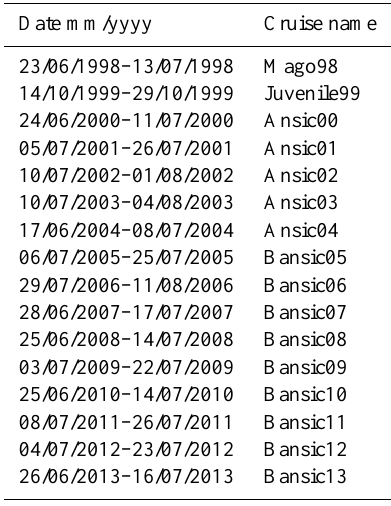
Table 1. Sampling period and name of the oceanographic surveys carried out in the Strait of